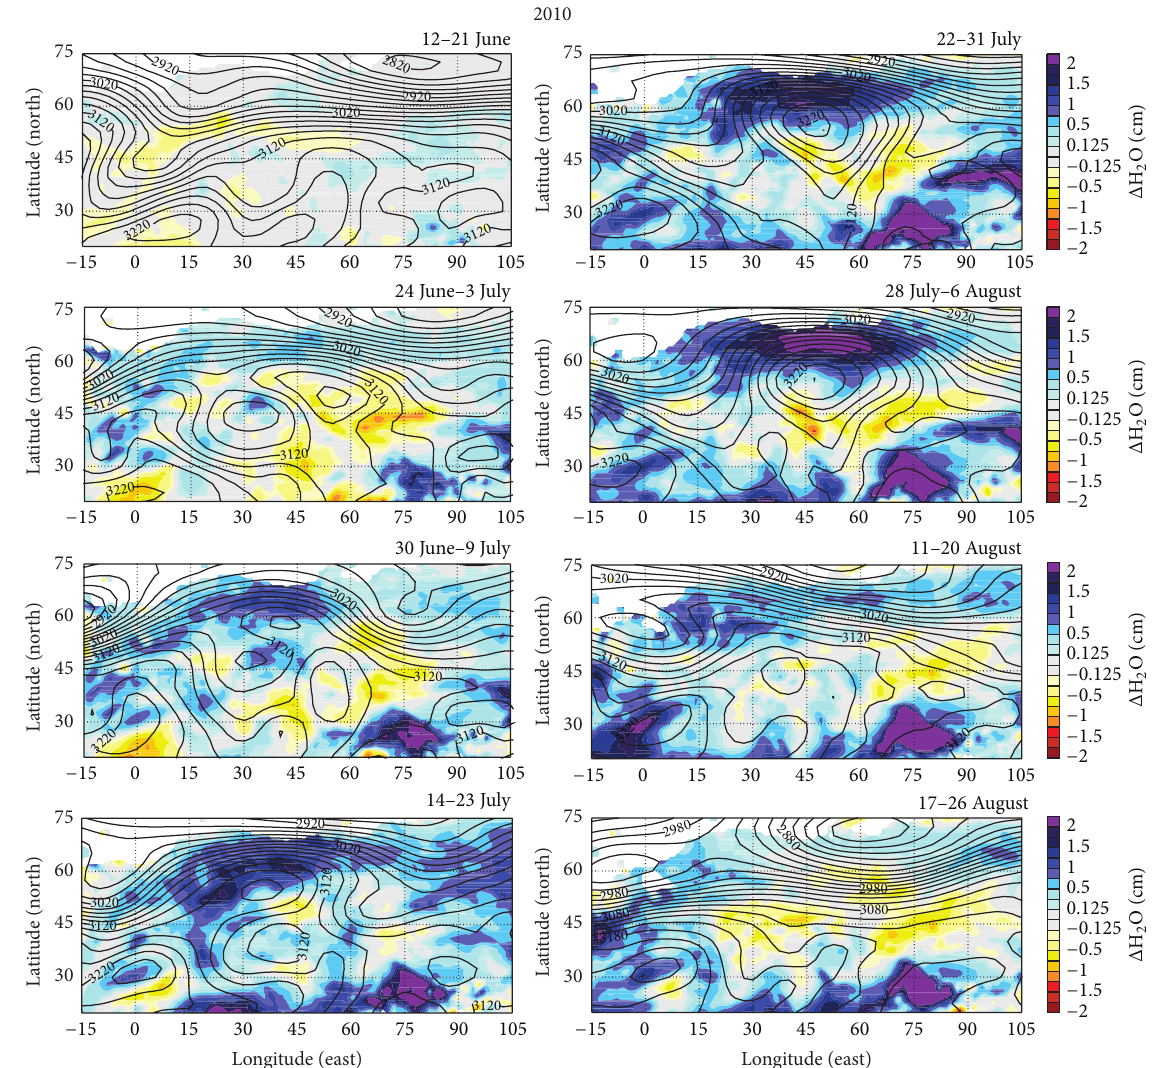
Figure 1: Differences between TCWV content averaged over 10-day periods (shown above each plot) and average TCWV content in the period 10–19 August 2010. Isolines are average 700 hPa heights for the same